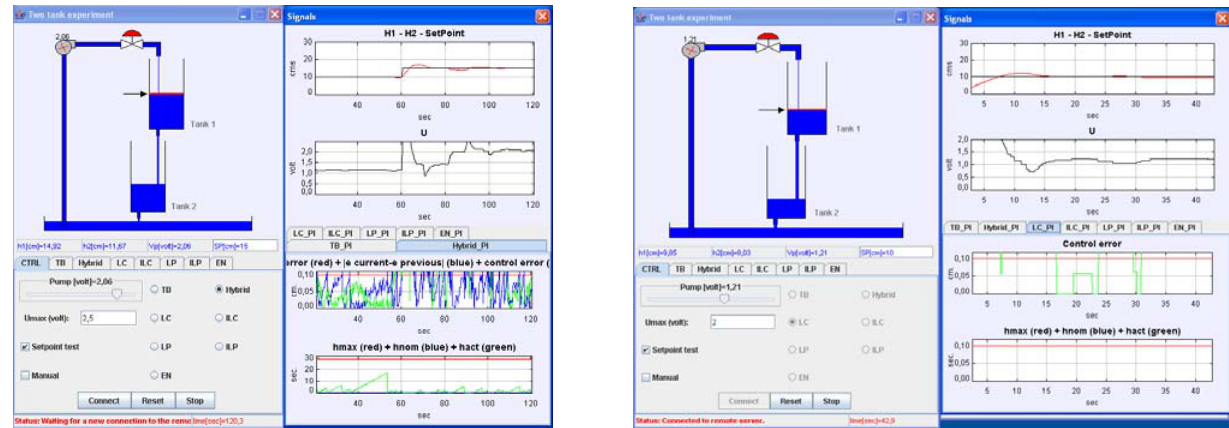
Figure 7. Client-side interfaces developed by Easy Java